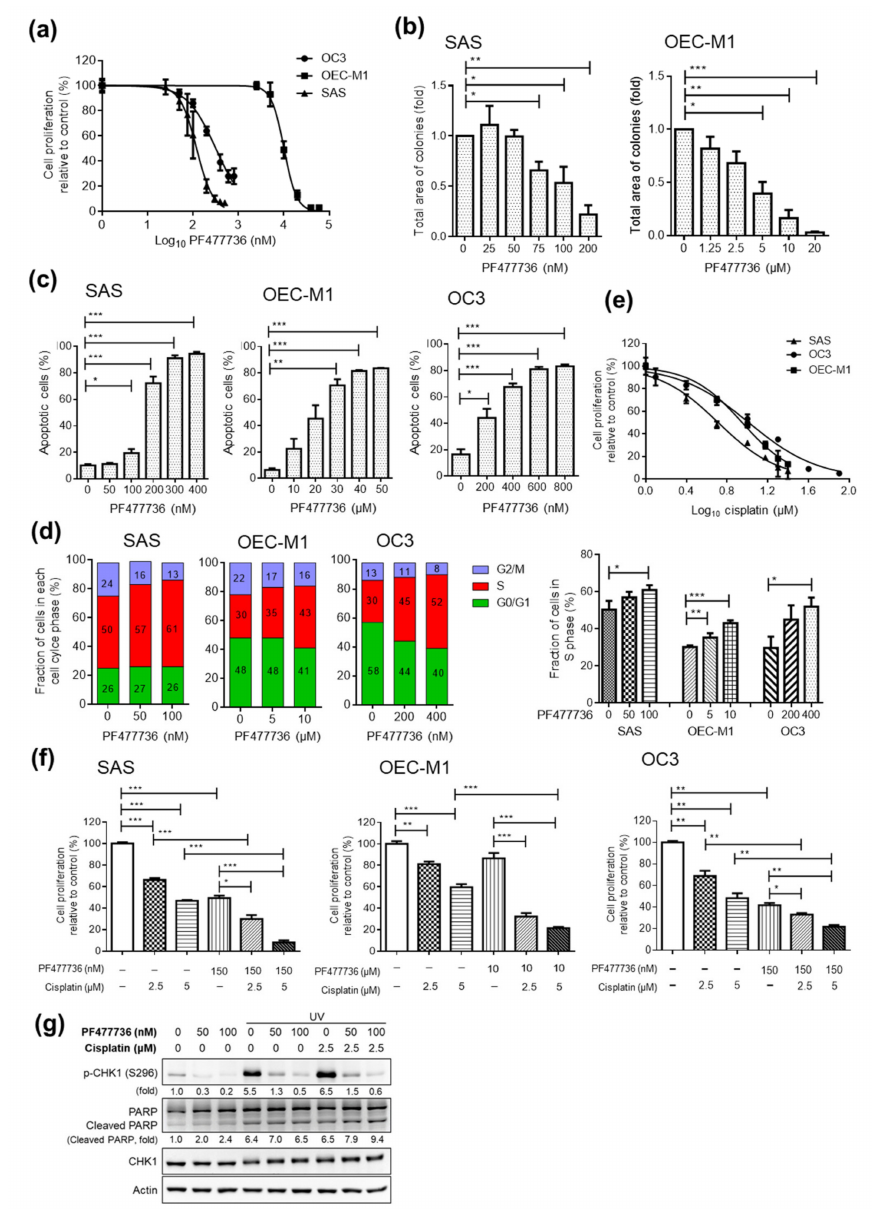
Figure 3. E ff ect of the CHK1 inhibitor PF477736 alone and in combination with cisplatin in OSCC cell lines. ( a ) Dose–response curve showing the cytotoxic e ff ect of treatment with a CHK1 inhibitor (PF477736) for 48 h in SAS, OC3, and OEC-M1 cells, as assessed by MTT assays. Colony formation assays ( b ) and annexin V staining ( c ) were performed with OSCC cells treated with PF477736 at the indicated concentration. ( d ) The cell cycle distribution of OSCC cells treated with the vehicle control or a CHK1 inhibitor (PF477736) for 24 h at various concentrations was assessed by propidium iodide staining. ( e ) Dose–response curve showing the cytotoxic e ff ect of treatment with cisplatin for 48 h in SAS, OC3, and OEC-M1 cells, as assessed by an MTT assay. ( f ) Cells were treated with PF477736 plus cisplatin for 48 h at the indicated concentrations, and an MTT assay was then performed. The data were replicated in three independent experiments. The results are expressed as the mean ± SEM. values. Statistical analysis of the di ff erences between the two groups was performed with a t -test. * p < 0.05; ** p < 0.01; *** p < 0.001. ( g ) SAS cells seeded in 6-well plates were exposed to UV radiation (70 mJ / cm 2 ) for 2 h. Then, the cells were treated with the CHK1 inhibitor PF477736 and / or cisplatin at the indicated doses for another 2 h. Cell lysates were collected, and Western blot analysis was performed to assess the levels of p-CHK1 (Ser296), PARP, and total CHK1. Actin was used as the loading